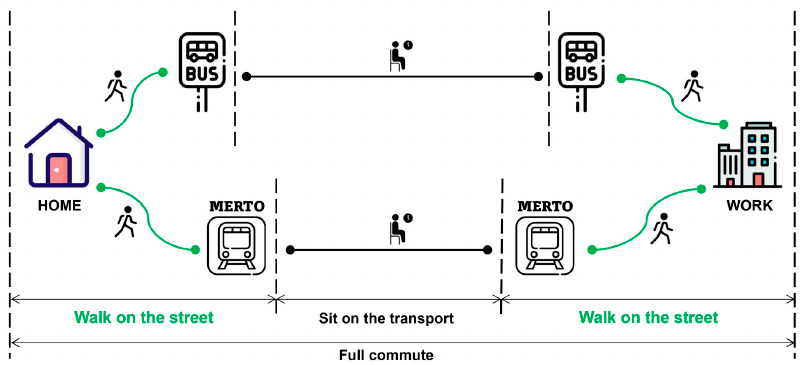
Figure 5. Illustration of the commuting